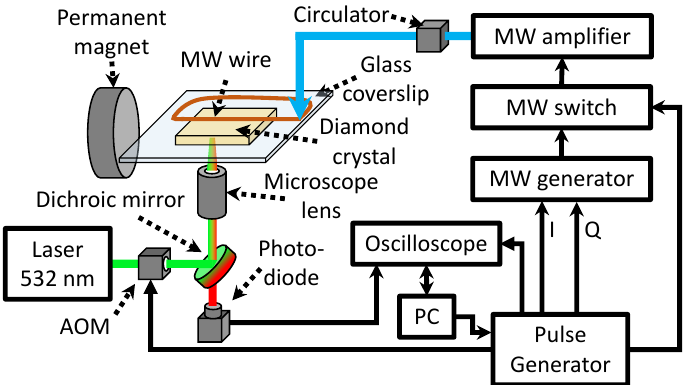
Figure 2. Schematic of the experimental apparatus. AOM: acousto-optic modulator; I and Q: phase shift control; PC: the personal